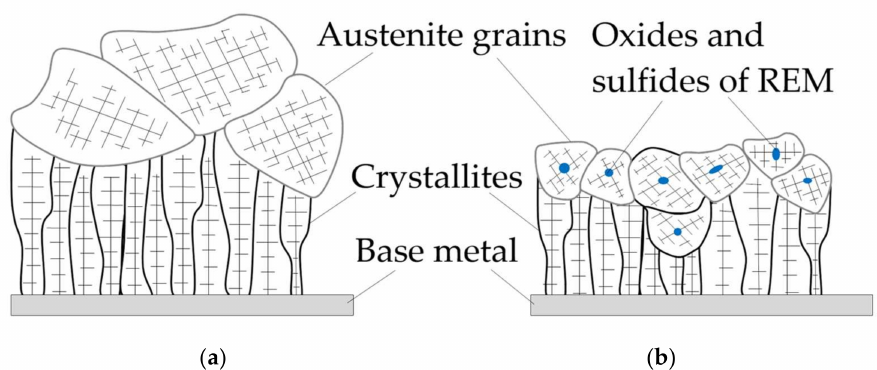
Figure 6. The model of dendritic crystallization at the boundary of “weld pool-base metal” transition: ( a ) without limiting the growth of crystallites; ( b ) with limiting the growth of crystallites involving additional crystallization nuclei, oxides, and